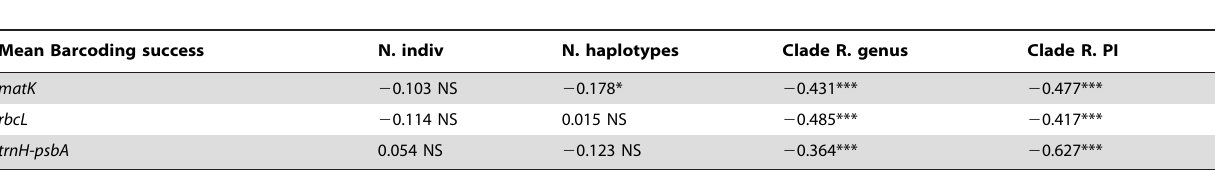
Table 3. Determinants of the barcoding success of African rain forest trees: Spearman’s correlation coefficients between the proportion of individuals correctly identified at the species level and the number of individuals (N. indiv), number of haplotypes (N. haplotypes), or clade richness (Clade R. genus, Clade R. 99% PI) per species in the